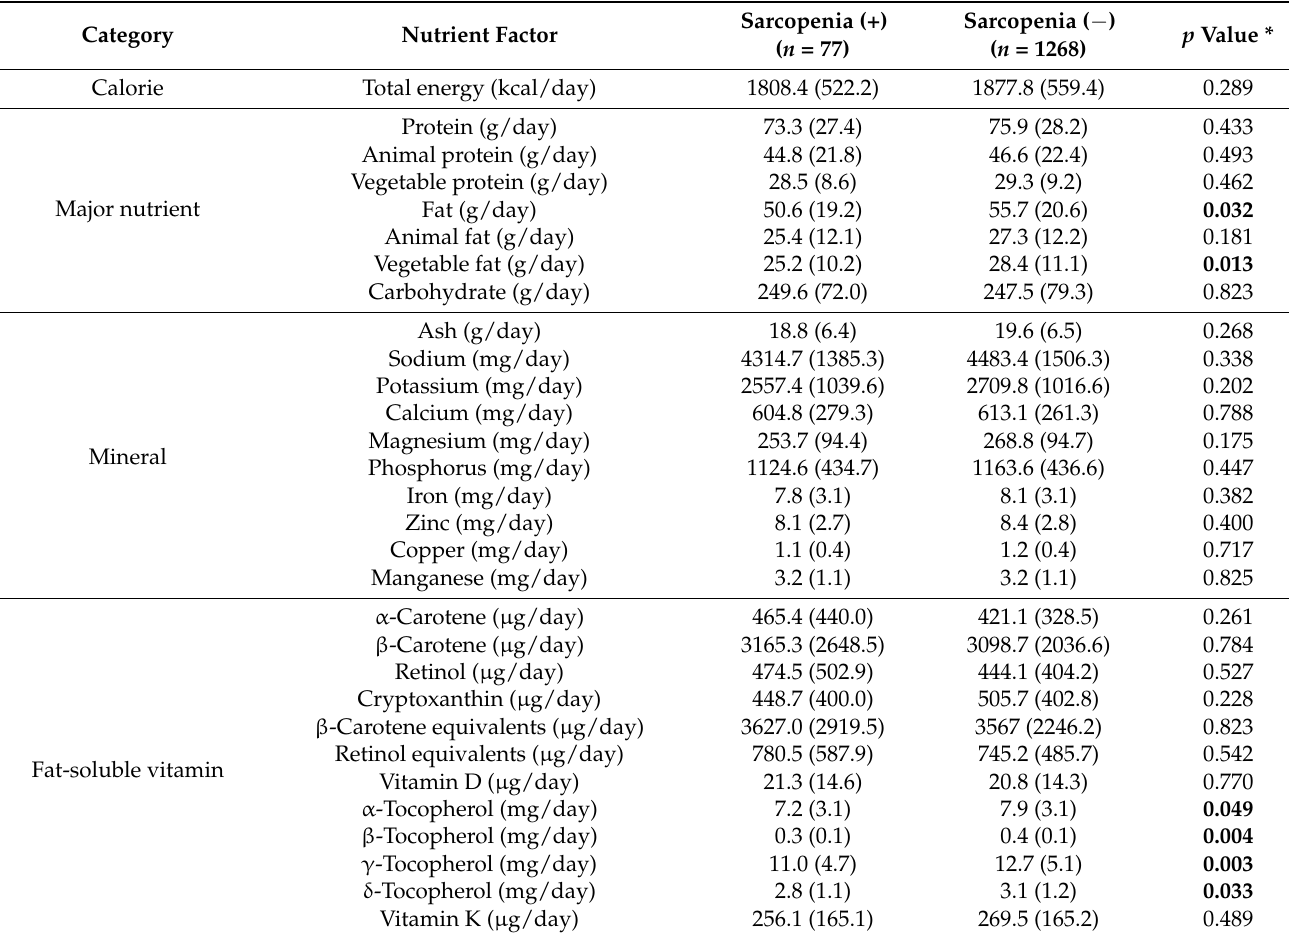
Table 2. Dietary intakes of total energy and 50 major nutrient factors in participants with and without